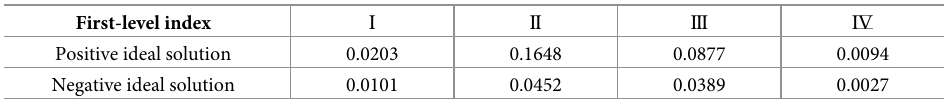
Table 2. Positive and negative ideal solution. First-level